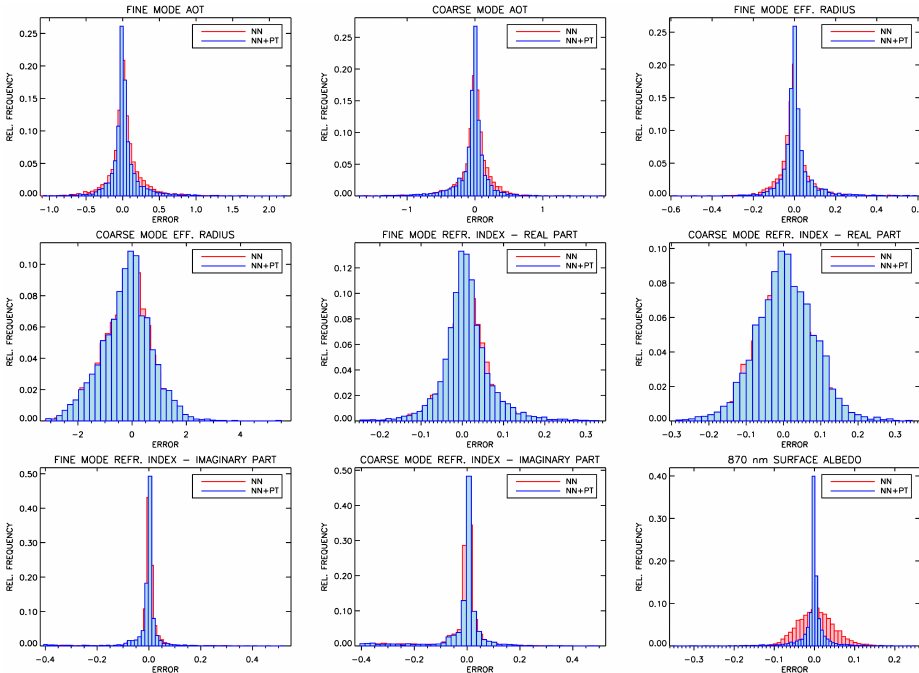
Figure 2. Histograms of the absolute errors in the retrieved parameters over the benchmark synthetic data set for the NN-only retrievals (red) and for the Phillips–Tikhonov retrievals with the NN-based first guess